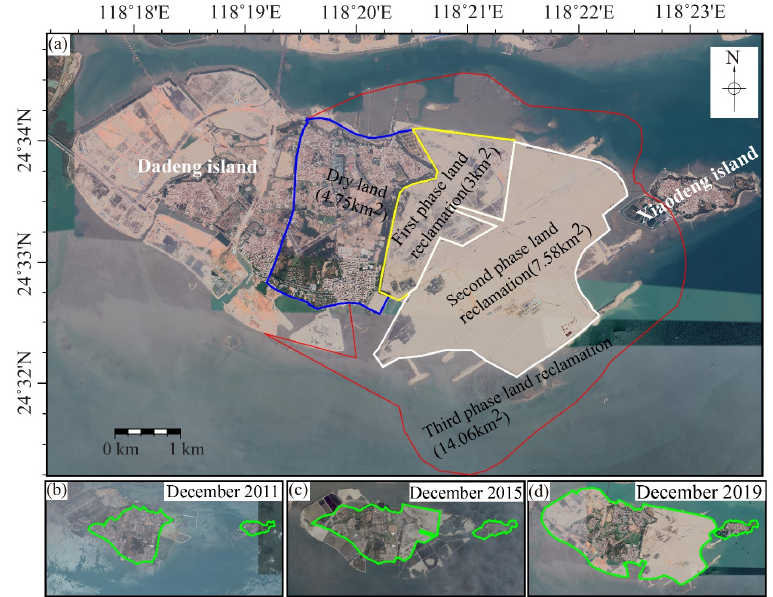
Figure 2. Optical images of the XXIA, Dadeng Island, and Xiaodeng Island: ( a ) illustration of the three phases of land reclamation. The yellow, white, and red lines are the boundaries of the reclaimed land in the first, second, and third phases, respectively. The blue line represents the dry land of Dadeng Island; ( b – d ) optical images of the study area acquired in December 2011, December 2015, and December 2019, respectively. The green lines delineate the boundaries of Dadeng Island and Xiaodeng Island. Table 1. Acquisition dates and parameters of the collected Sentinel-1